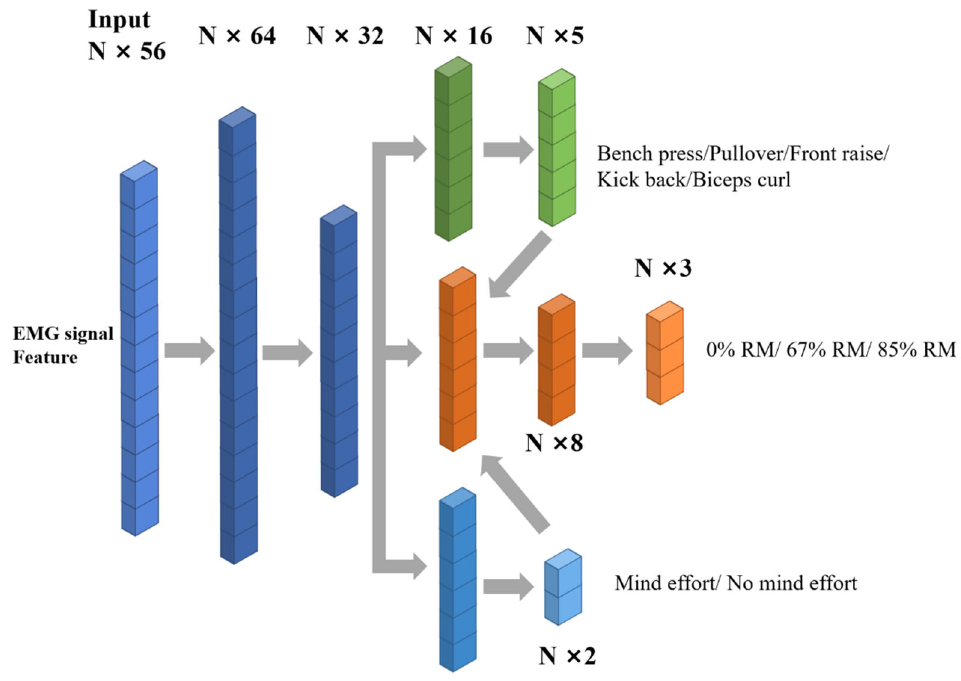
Figure 5. Multitask and Multiclassification Networks.